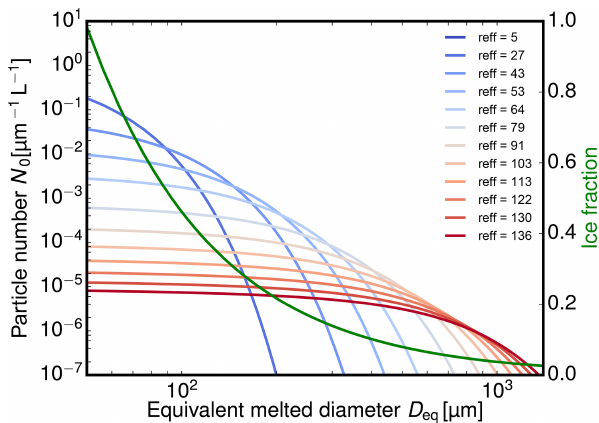
Figure 8. The ice microphysical model used during the effective re- flectivity study. The particle size distribution (Delanoë et al., 2005) and the mass–size relationship (green curve) (Heymsfield et al., 2010) are based on an extensive database of airborne in situ mea-